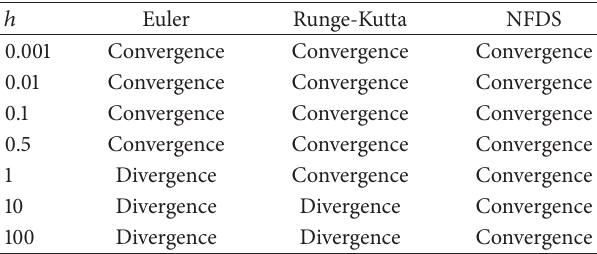
Table 2: Qualitative results of the fixed point 𝑋 ∗ 2 for different time step sizes, 𝑟 = 0.001 , 𝑡 = 0–500.